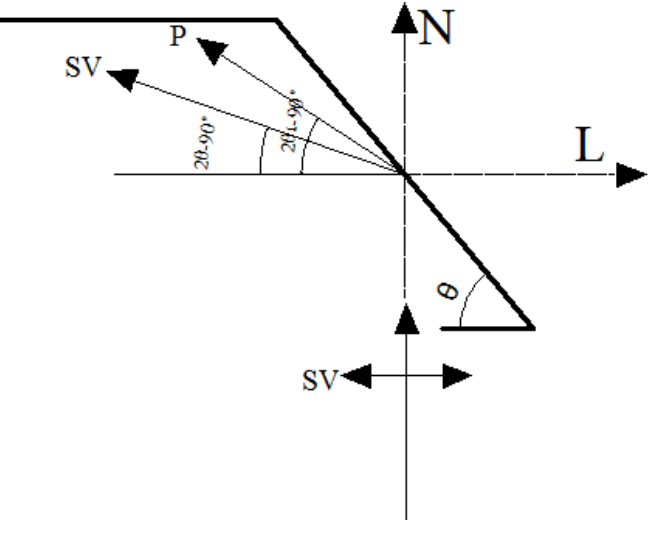
Figure 17. The division of the SV wave